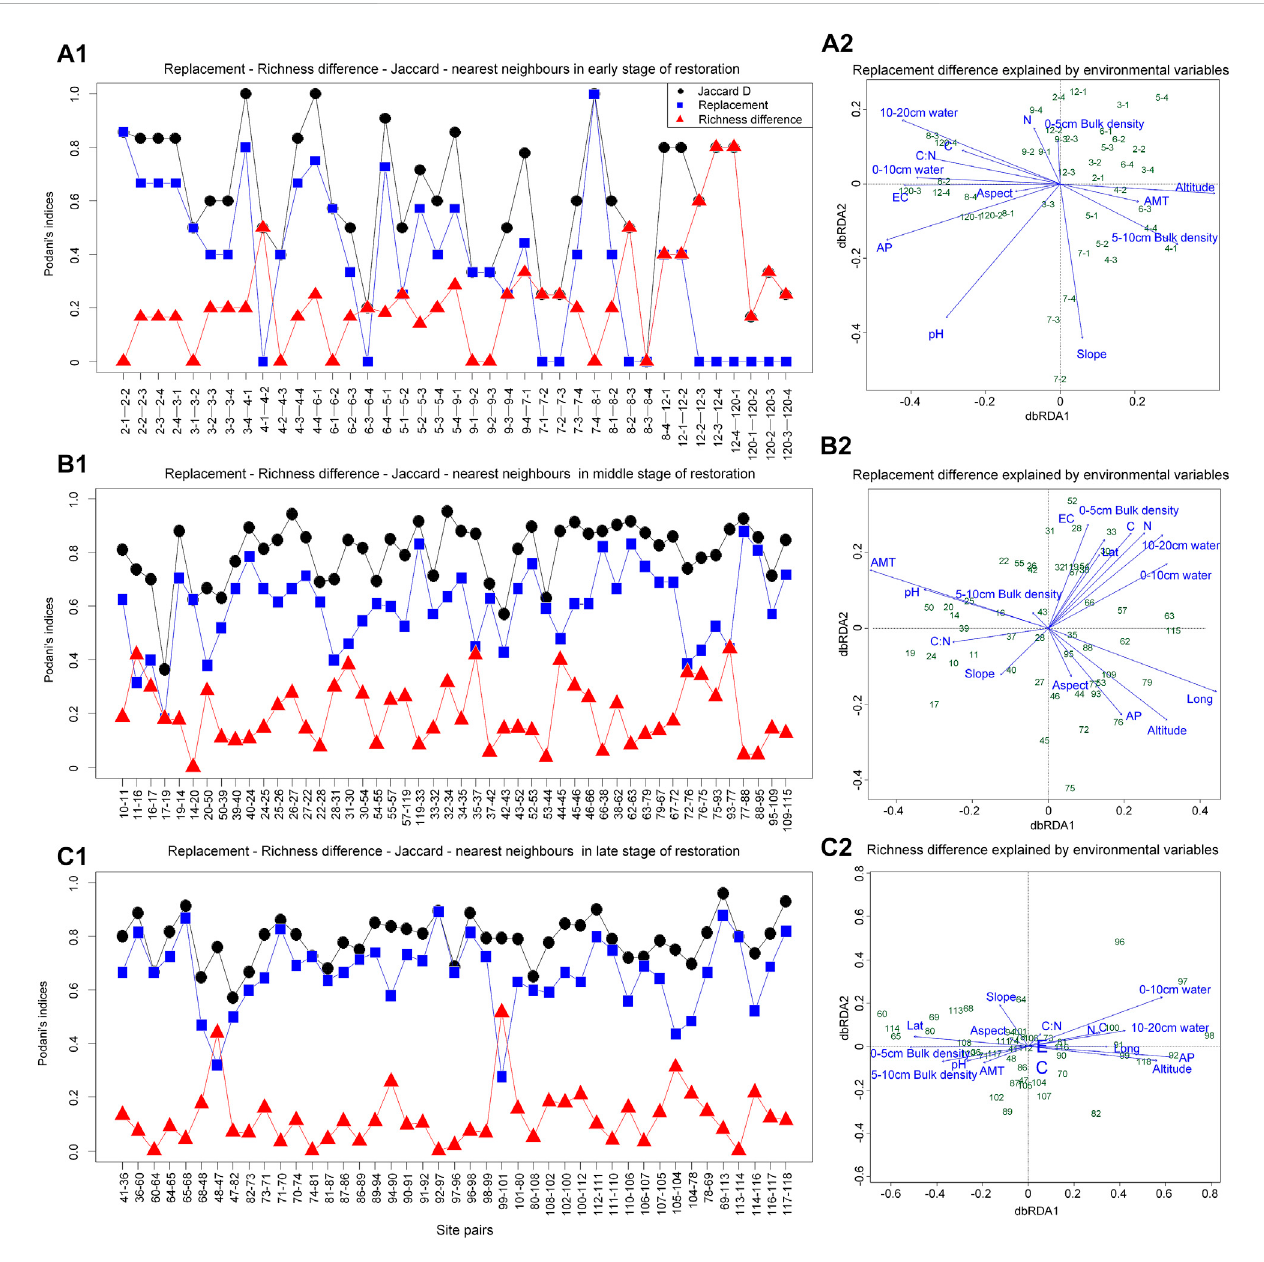
FIGURE 4 The reasons for differences among communities. C, total carbon; N, total nitrogen; EC, electrical conductivity; AP, annual precipitation; AMT, annual meantemperature;Lat,latitude;Long,longitude.ThesitenumberscorrespondtothenumbersofthesamplingpointsinFigure1.Thesamplepointdataatthe initial stage of restoration (Figure 4A1) is not averaged (that is, four replicates are used) to meet the sample size required for